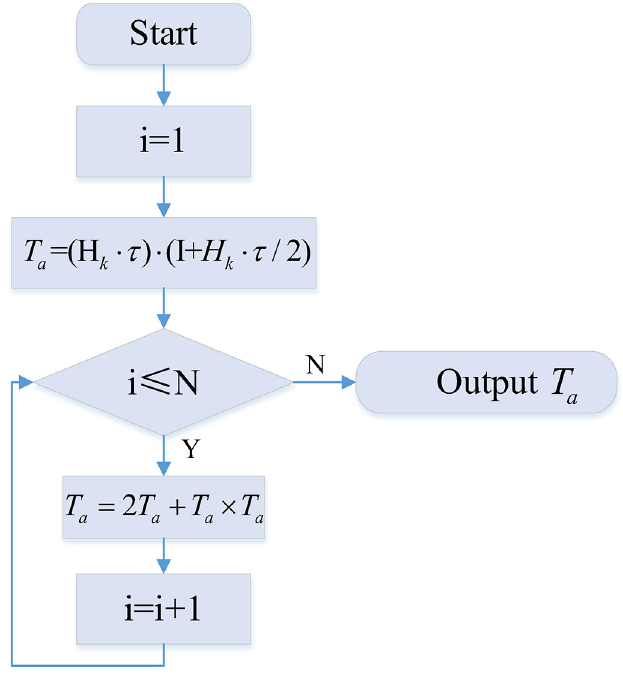
Fig. 2. Operation fl ow